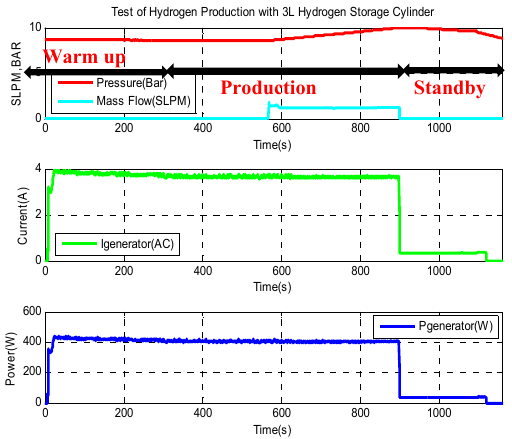
Figure 5. Experimental responses of the hydrogen electrolysis